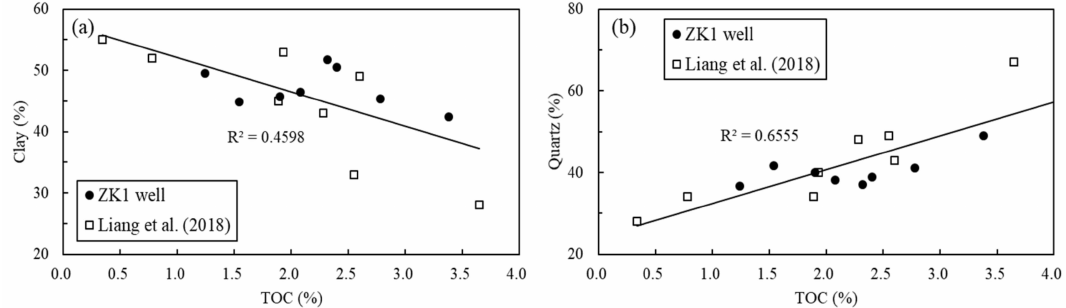
Figure 5. Plots of TOC content versus clay content ( a ) and quartz content ( b ) in the Taiyuan marine shale. The data were obtained from the ZK1 well and from Liang et al. (2018)